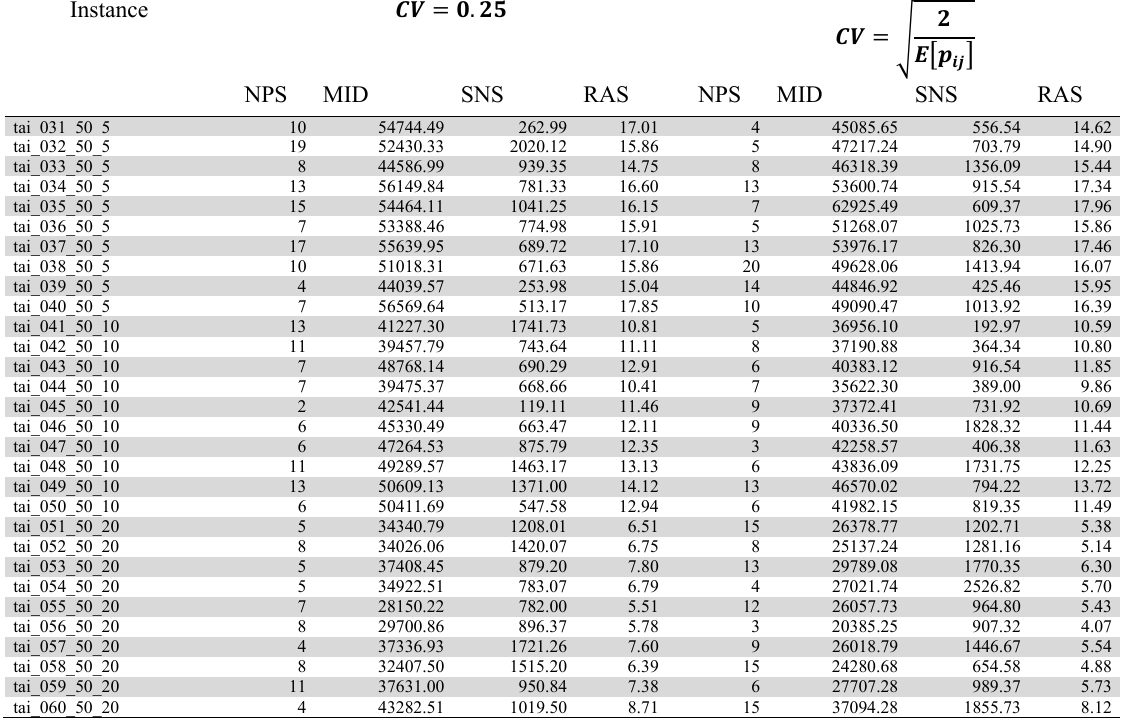
Table 8 Multi-objective indicators for instances of 50